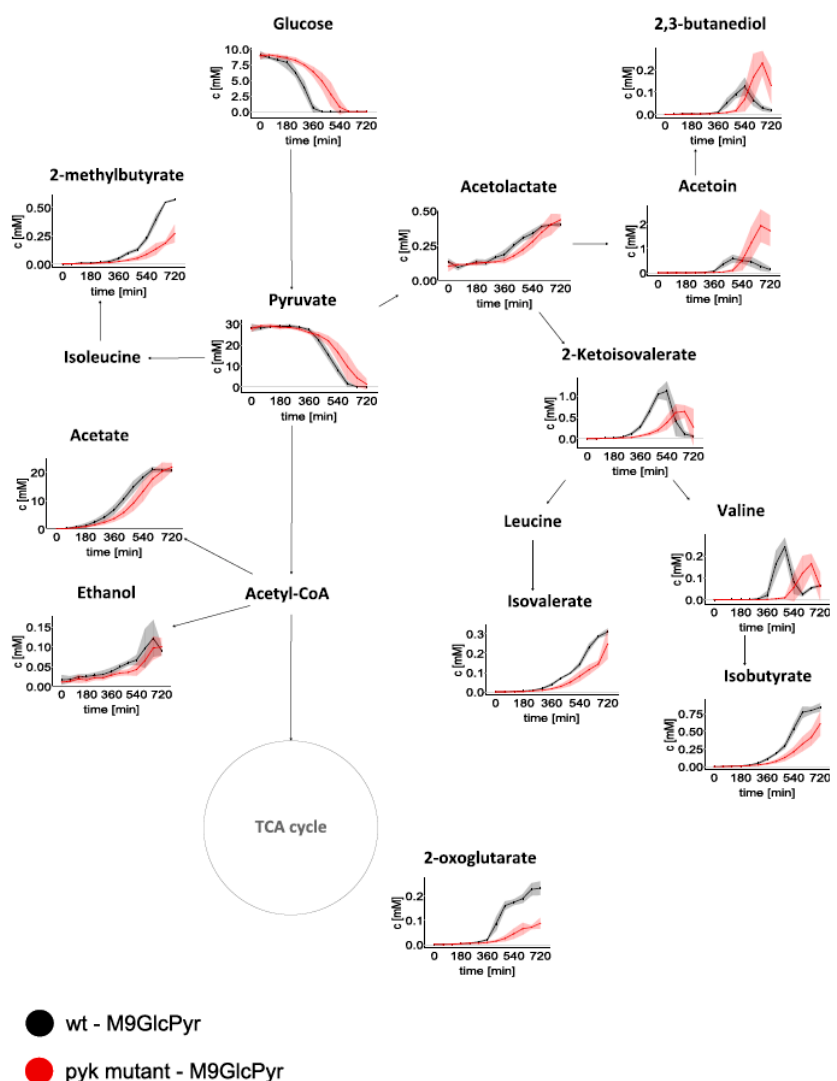
Figure 2. Time-resolved extracellular metabolites under M9GlcPyr medium cultivation. Absolute concentrations of consumed and secreted metabolites by wt (black) and Δ pyk (red) are displayed. Data are represented as the mean concentrations ± SD (shaded) of quadruplicate samples. Table 1. Glucose and pyruvate concentrations (mM) present in the supernatant during the time cultivation of wt and ∆ pyk. Data are shown as the mean values ± SD of quadruplicate samples. wt ∆ Time (min)